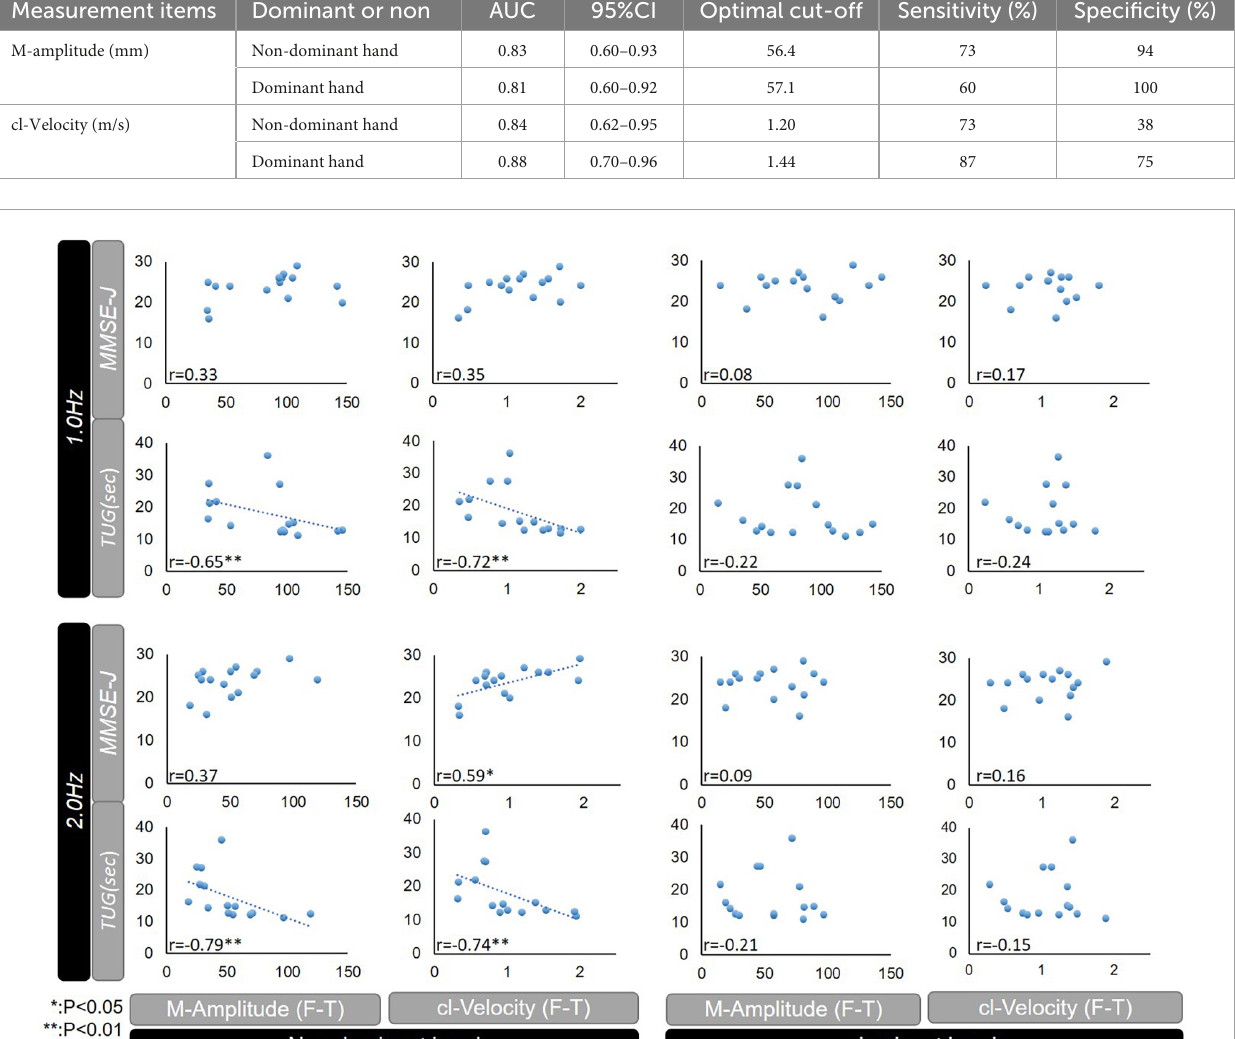
TABLE 3 Areas under curves of m-amplitude and cl-velocity.